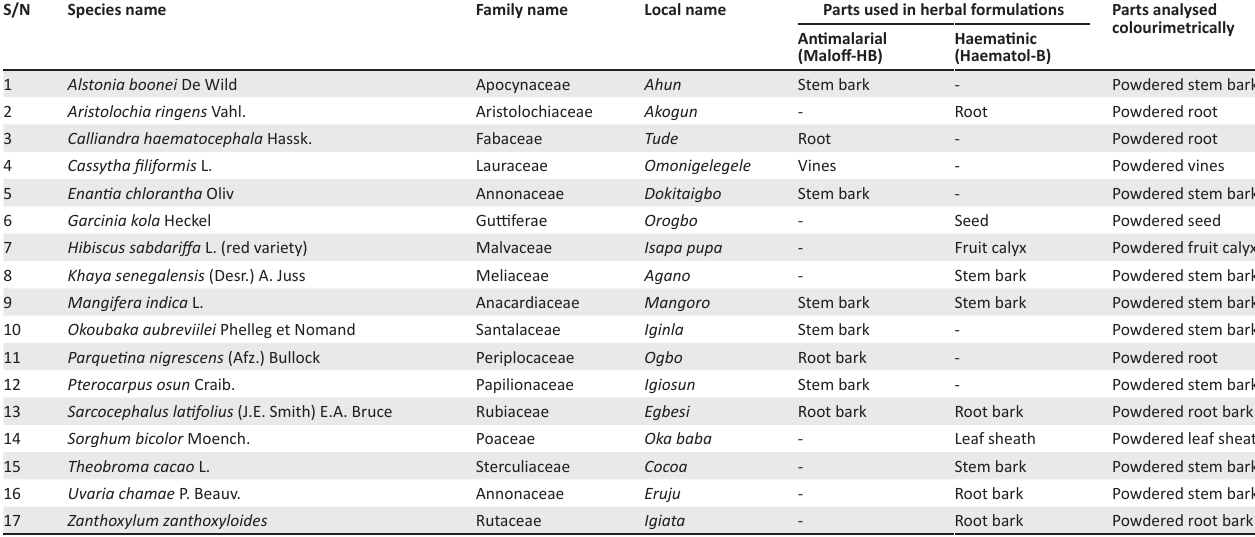
TABLE 1: A list of the plant parts used for two powdered herbal formulations (Maloff-HB and Haematol-B) in Ogbomoso for the colorimetric